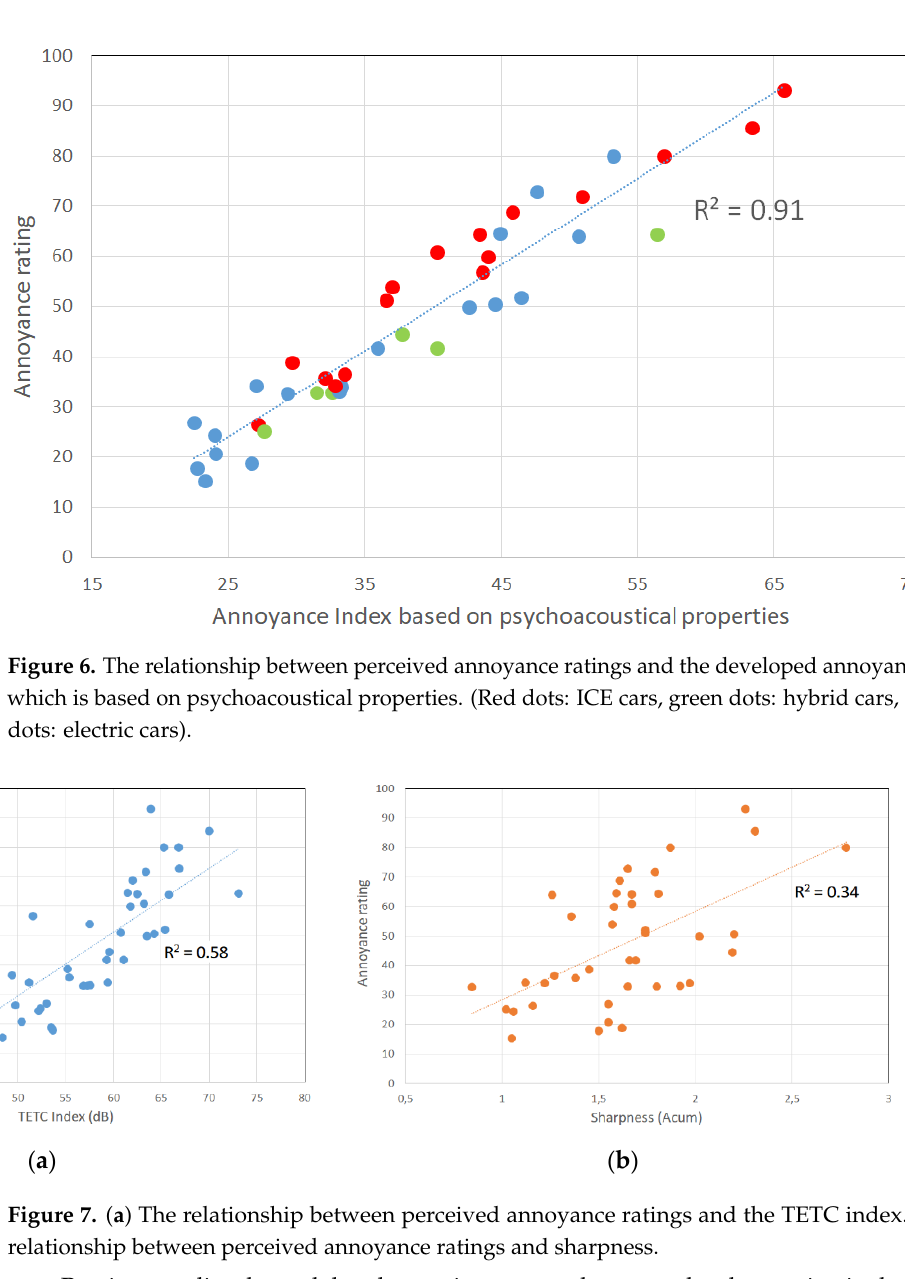
Figure 5. The relationship between perceived annoyance ratings and the maximum sound pressure level in dB(A). (Red dots: ICE cars, green dots: hybrid cars, and blue dots: electric cars).